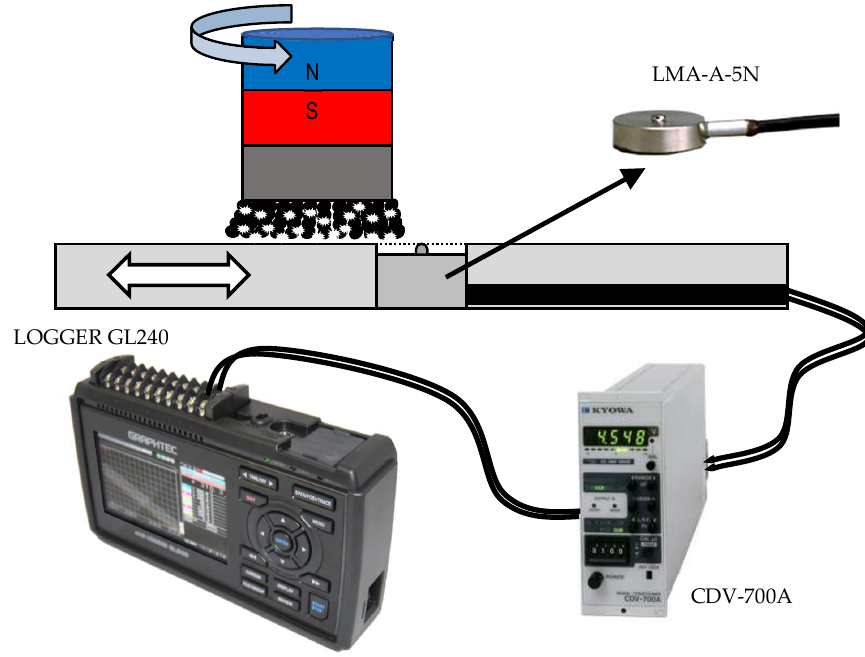
Figure 8. Schematic diagram of pressure measuring device structure.